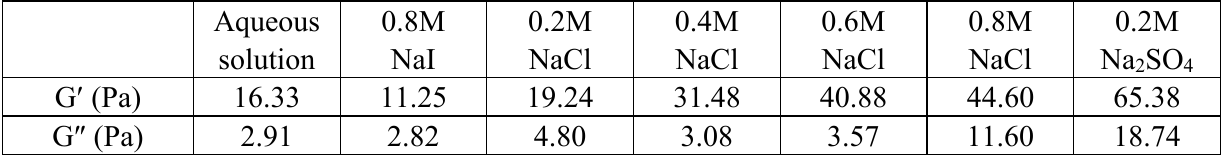
Table 3. G  and G  for HPMC aqueous solutions with various salts and salt concentrations measured at 70 °C, 1 rad/s frequency and 5 wt%